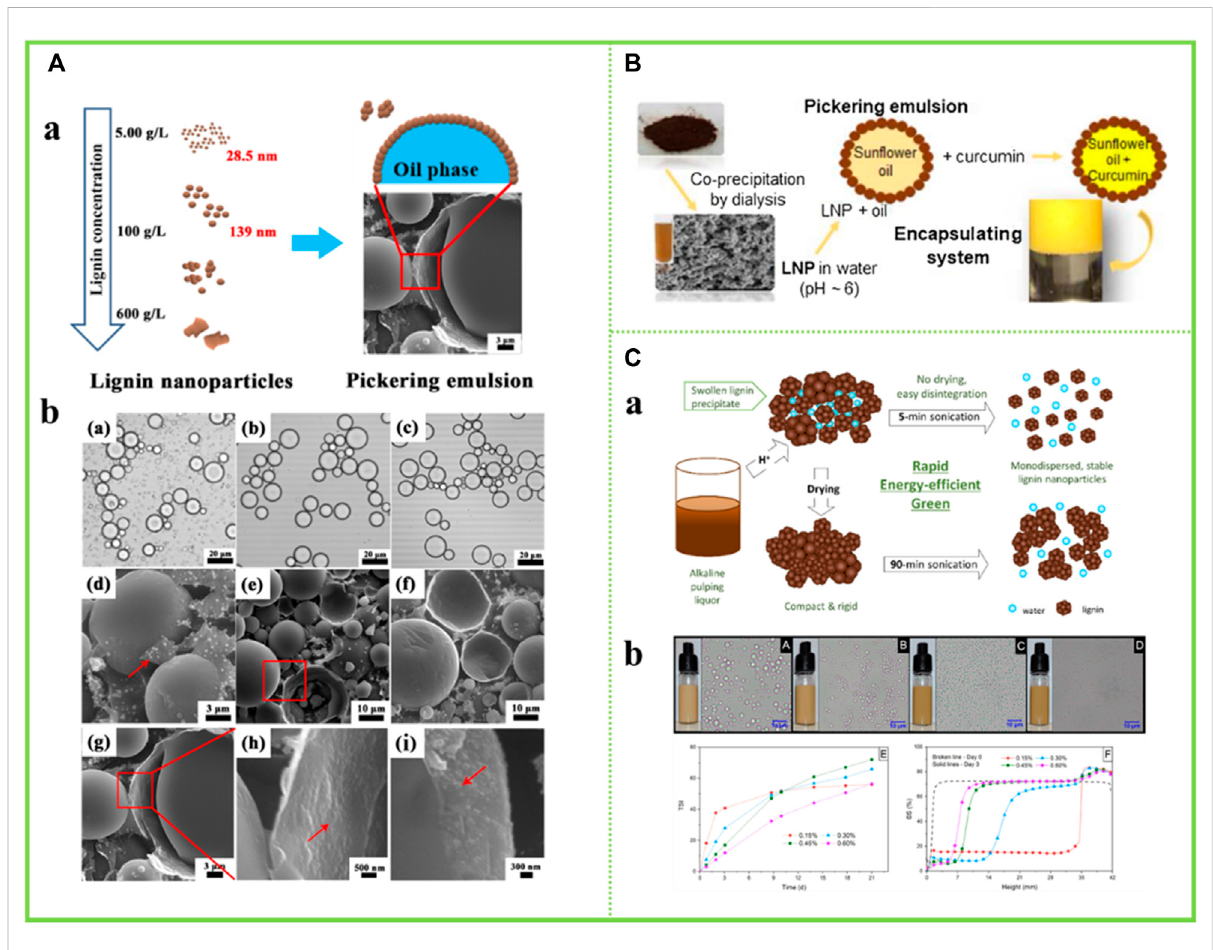
FIGURE 12 (A) Synthesis and application of LNCs, O.M. images of Pickering emulsions of thyme oil in water stabilized (Li et al., 2021) (B) An illustration of LNCs-stabilized Pickering emulsions (Qian et al., 2015a) (C) Application of particles in Pickering emulsion (Agustin et al., 2019). (A) Copyright 2021 American Chemical Society (B) Copyright 2015 Elsevier (C) Copyright 2019 American Chemical